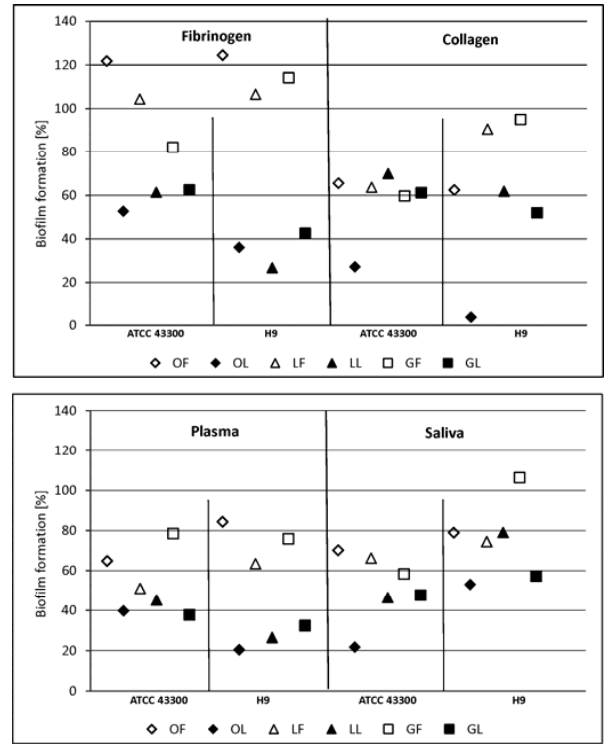
Figure 2. Staphylococcus aureus ATCC 43300 and clinical S. aureus H9 biofilm formation on the surface conditioned with host-derived proteins/body fluids (fibrinogen, collagen, plasma, saliva) in the presence of subMICs of fractionated sea buckthorn (SBT) extracts. LF, GF, OF denote phenolic fractions of leaf, twig, and fruit-derived extracts, respectively; LL, GL, OL denote nonpolar (lipid) fractions of leaf, twig, and fruit-derived extracts, respectively. Inhibitory effect was analyzed in terms of metabolic activity of biofilm mass by LIVE/DEAD BacLight Bacterial Viability kit ( S. aureus ). The percentage ± S.D. of biomass activity compared with the control (untreated), which was considered as 100%, is presented.